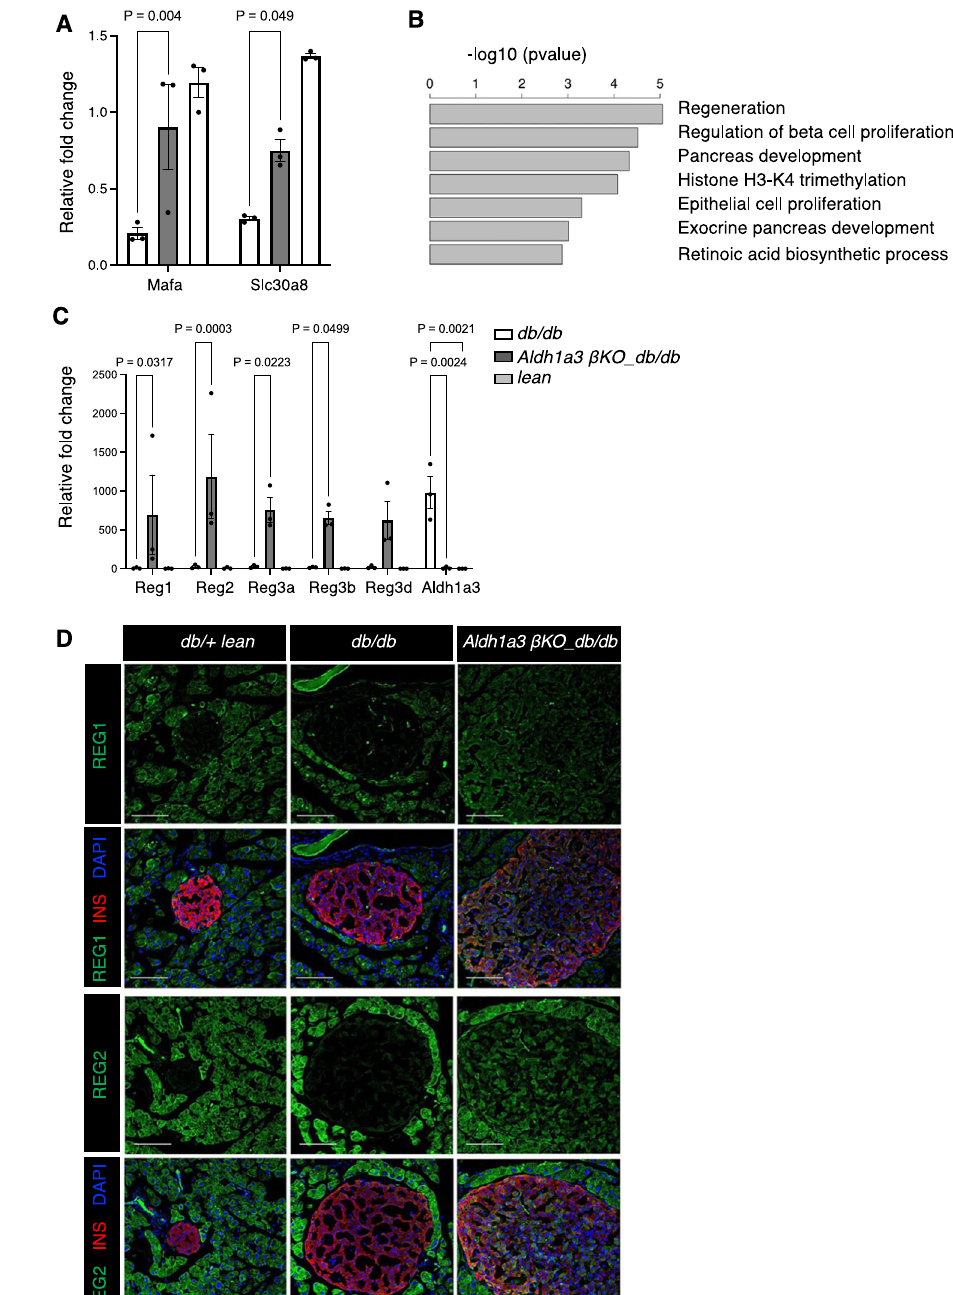
( A ).Data are expressedasmeans±SEM for n =3 biologicallyindependent samples per group. Two-way ANOVA with multiple comparison test was used for statistical analysis. D Co-immunostaining of REG1 or REG2 (green), insulin (Red) and DAPI (blue) in db/+ (left), db/db (middle) or β -Aldh1a3 KO_db/db (right) pancreata. Representative immuno fl uorescence images of n =4 mice per group. Scale bars: 100 μ M. Source data are provided as a Source Data fi